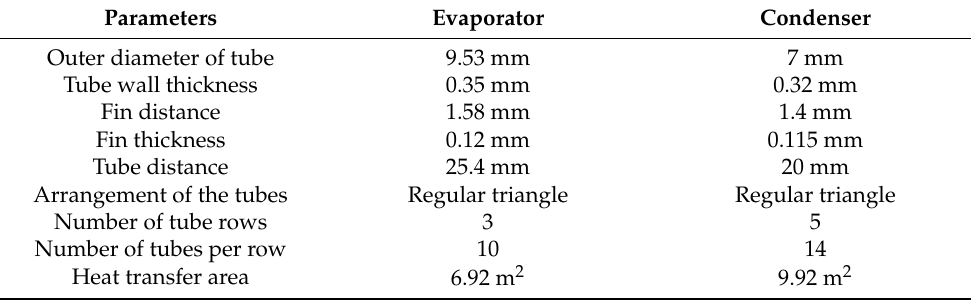
Table 1. Structural parameters of evaporator and condenser. Parameters Evaporator Condenser Outer diameter of tube